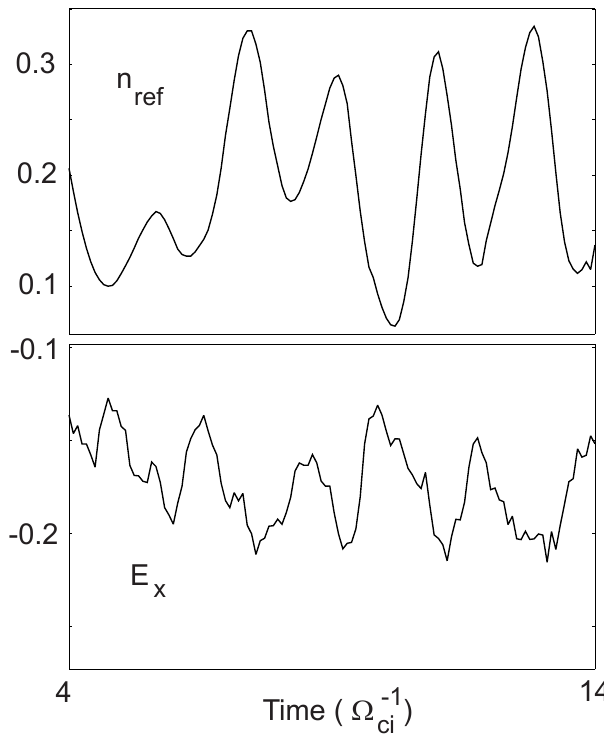
Fig. 13. Same as Fig. 11 for the ion to electron mass ratio 1840 case. For details see